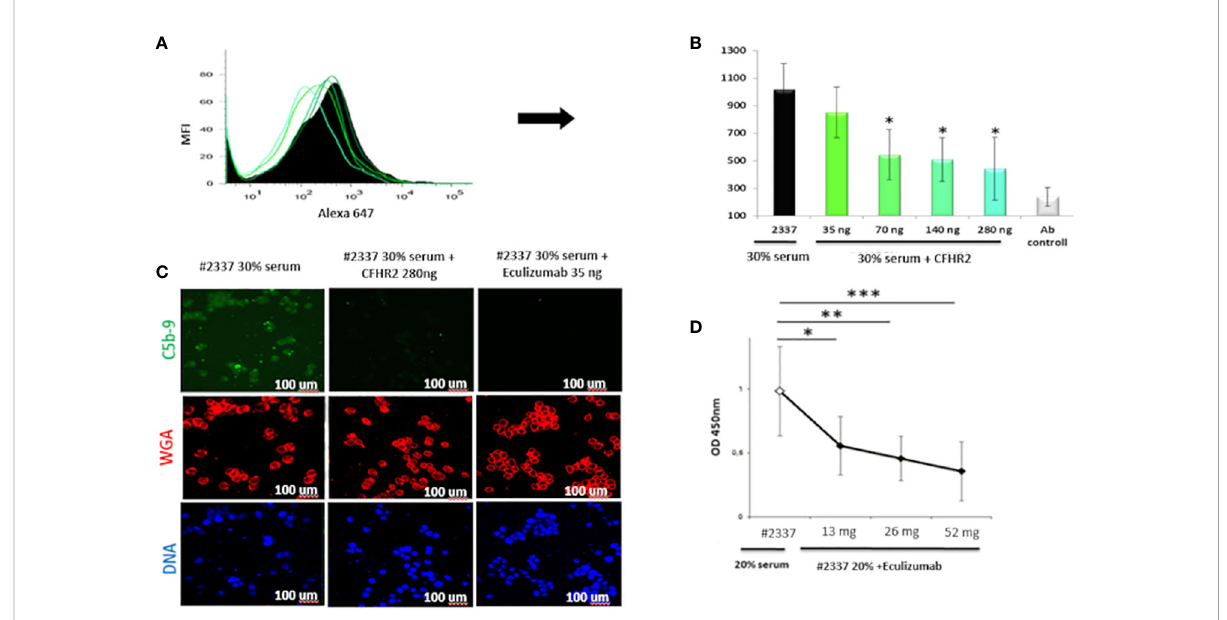
FIGURE 4 Recombinant FHR2 and eculizumab block C5b – 9 deposition by HS#2337. (A, B) Endothelial cells were incubated with HS#2337 (30%) for 30 minutes. An increasing amount of recombinant FHR2 was added to HS#2337 serum and C5b – 9 signaling was examined by fl ow cytometry. Antibody (Ab) control represents no interaction. The recombinant FHR2 reduced, in a dose-dependent manner, C5b – 9 deposition on HUVECs, and this reduction was statistically signi fi cant at 70 ng, 140 ng, and 280 ng of FHR2. MFI, mean fl uorescence intensity. The results are mean ± standard deviation (SD) of three independent experiments. (C) The effects of eculizumab and FHR2 on C5b – 9 deposition was compared by laser scanning microscopy. HUVECs were incubated with 30% HS#2337serum, with 30% HS#2337serum premixed with 280 ng of FHR2 and with 30% HS#2337 serum premixed with eculizumab (35 ng). C5b – 9 deposition was evaluated using the monoclonal C5b – 9 antibody. (D) Increasing amounts of eculizumab (from 0 to 52ng) were added to 20% HS#2337, and the effect on C5b – 9 generation was evaluated by